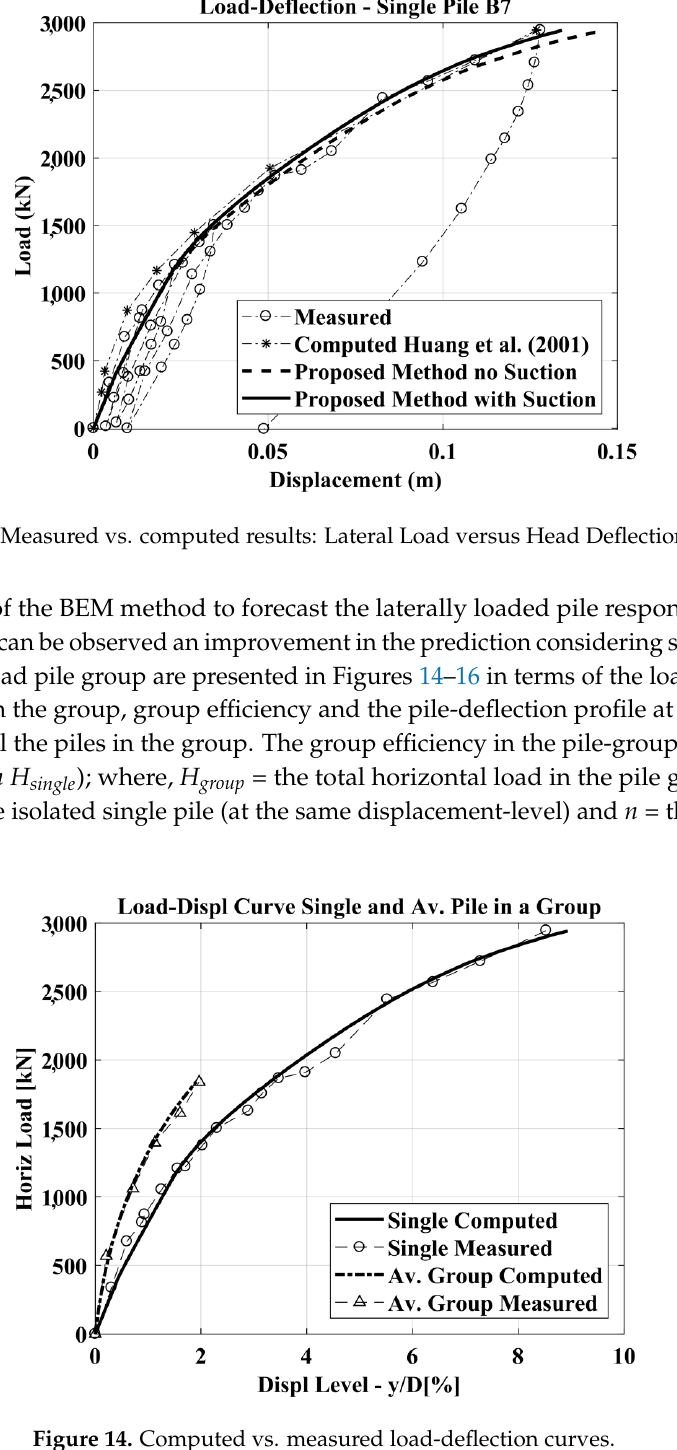
Figure 15. Computed vs. measured group efficiency.